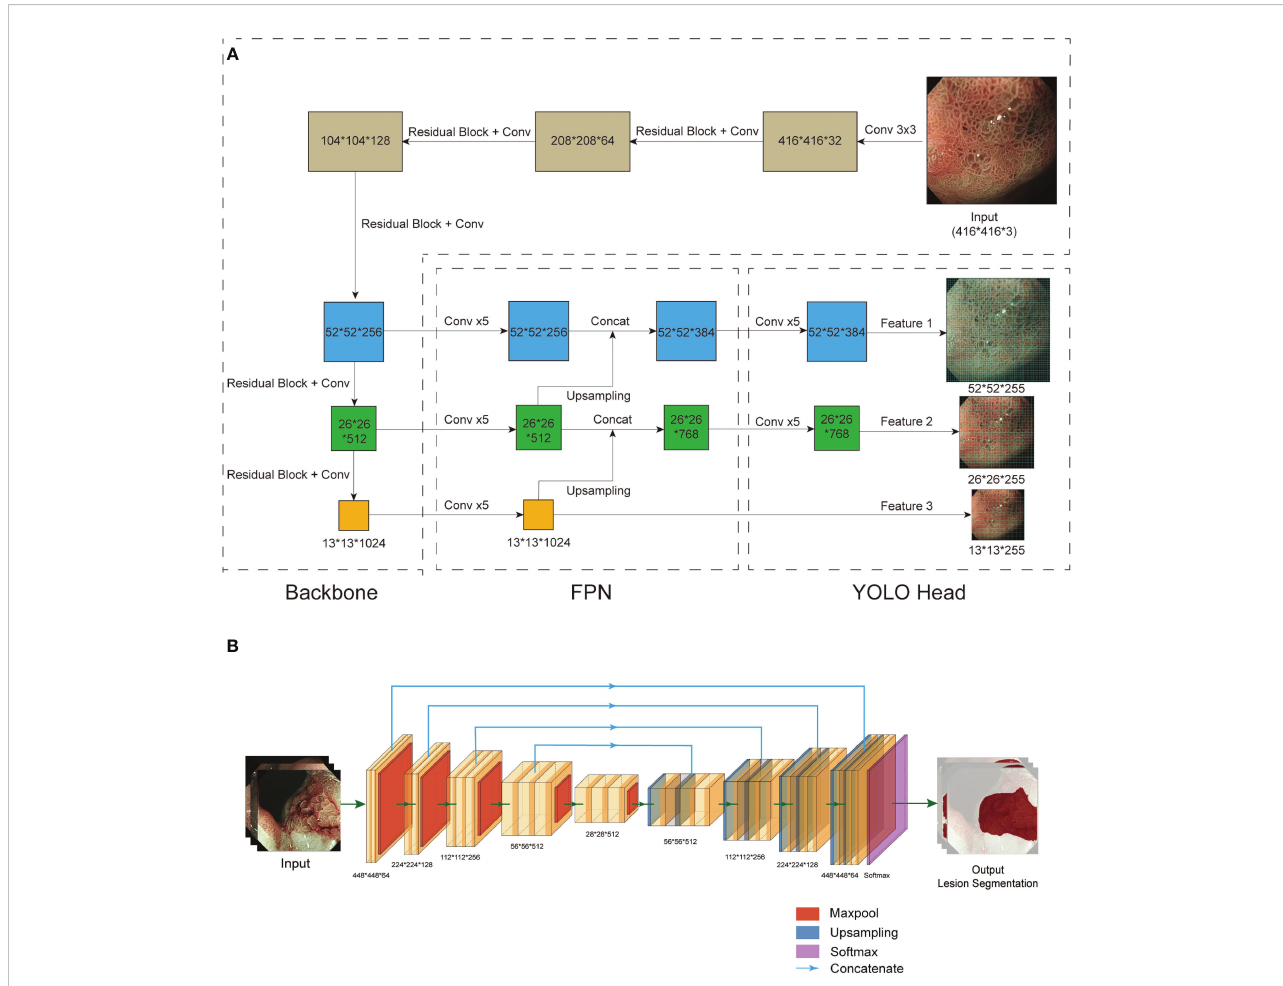
FIGURE 3 Structure of CNN1 and CNN2. (A) CNN1 is based on the YOLO v3 network. Based on the results of the pre-experiment, we chose Ef fi cientNet B2 to replace Darknet53 as the backbone for feature extraction. An FPN structure was used for the fusion of feature layers to combine different information about the features. Three effective feature layers of different sizes obtained by Ef fi cientNet B2 and FPN were regressed and classi fi ed by YOLO Head. (B) CNN2 is based on UNet. To obtain better feature extraction, we used pretrained VGG-16 instead of UNet ’ s backbone (left). After a series of upsampling and concatenation operations, the 5 effective feature layers extracted by VGG-16 were dimensionally superimposed and convolved twice (right). Finally, the fi nal segmentation result was output after a softmax function. CNN, convolutional neural network; FPN, feature pyramid